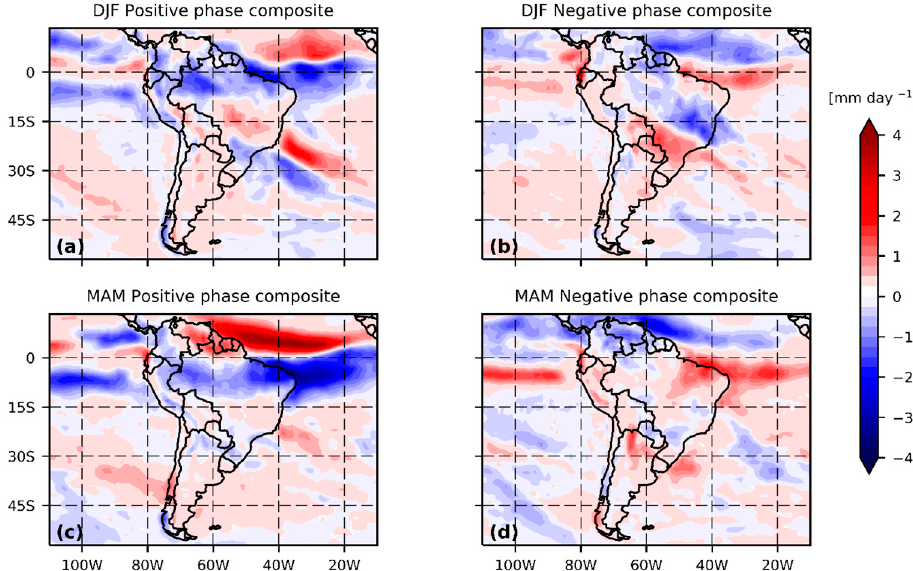
Figure 6. ( a ) DJF anomalies of the vertical integral of divergence of moisture flux corresponding to the composite of the 10 years with the maximum magnitude of PC3; ( b ) As in ( a ) but for the 10 years with the minimum magnitude of PC3; ( c ) MAM Anomalies of the vertical integral of divergence of moisture flux corresponding to the composite of the 10 years with the maximum magnitude of PC3; ( d ) As in ( c ) but for the 10 years with the minimum magnitude of PC3. Note that blue colors are related to more moisture, whereas the red colors indicate the opposite. Anomalies are defined as the deviation from the average for the period, 1931–2010. Data from ECMWF ERA-20C reanalysis. Based on these results, it is hypothesized that PC3 is related to simultaneous meridi- onal shifts of the ITCZ and the SACZ. In order to test this hypothesis, composites of the zonal average of the vertical velocity, ω , at 700 hPa, between 80° W and 15° W, are